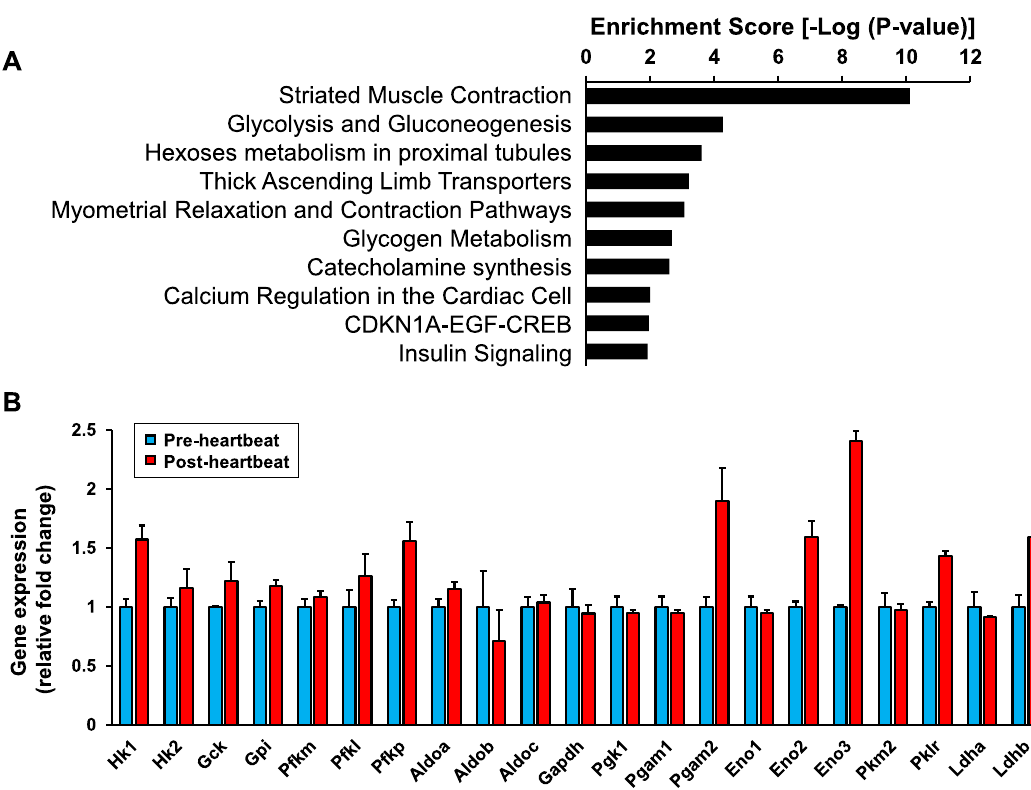
Figure 5. Pathway enrichment analysis for biological and physiological pathways that are up-regulated in the heart primordium after heartbeat initiation. ( A ) Top 10 pathways assessed by pathway enrichment analysis for biological and physiological pathways that were up-regulated by 1.5 fold or more in the post-heartbeat group compared with those in the pre-heartbeat group. ( B ) Individual values of relative gene expression of enzymes in glycolysis that are included in the pathway of “Glycolysis and Gluconeogenesis” in the pre- and post-heartbeat groups. Hk1 = Hexokinase-1, Hk2 = Hexokinase-2, Gck = Glucokinase, Gpi = Glucose- 6-phosphate isomerase, Pfkm = 6-phosphofructokinase muscle type, Pfkl = 6-phosphofructokinase liver type, Pfkp = 6-phosphofructokinase platelet type, Aldoa = Aldolase A, Aldob = Aldolase B, Aldoc = Aldolase C, Gapdh = Glyceraldehyde-3-phosphate dehydrogenase, Pgk1 = Phosphoglycerate kinase 1, Pgam1 = Phosphoglycerate mutase 1, Pgam2 = Phosphoglycerate Mutase 2, Eno1 = Enolase 1, Eno2 = Enolase 2, Eno3 = Enolase 3, Pkm2 = Pyruvate kinase M2, Pklr = Pyruvate kinase L/R, Ldha = Lactate dehydrogenase A, Ldhb = Lactate Dehydrogenase B.